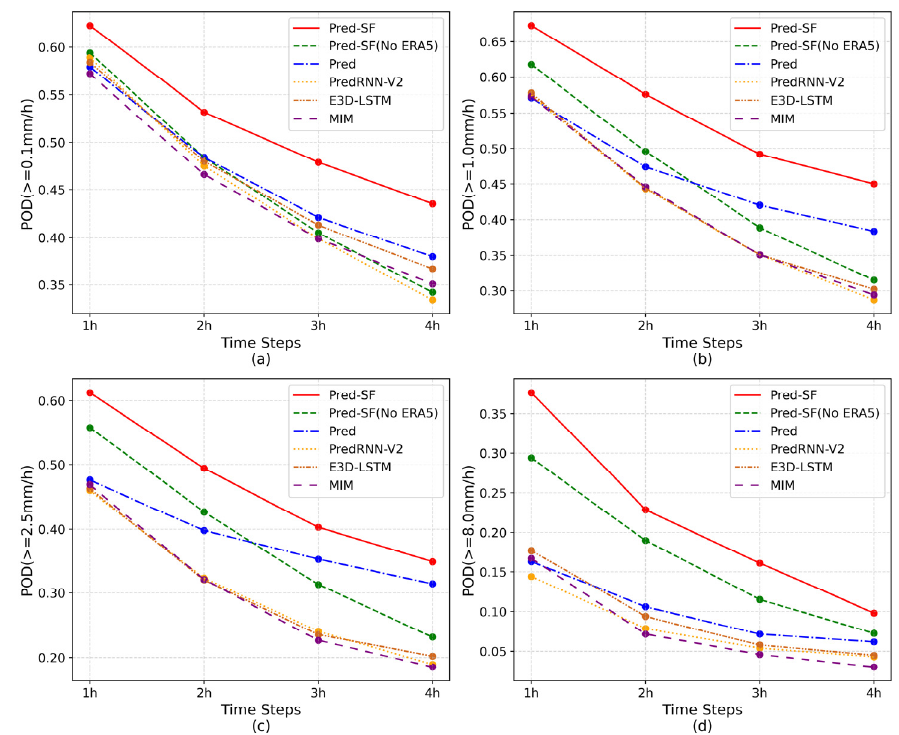
Figure 5. POD index of the six groups of models at each prediction moment: ( a ) precipitation is greater than 0.1 mm/h; ( b ) precipitation is greater than 1.0 mm/h; ( c ) precipitation is greater than 2.5 mm/h; ( d ) precipitation is greater than 8.0 mm/h.